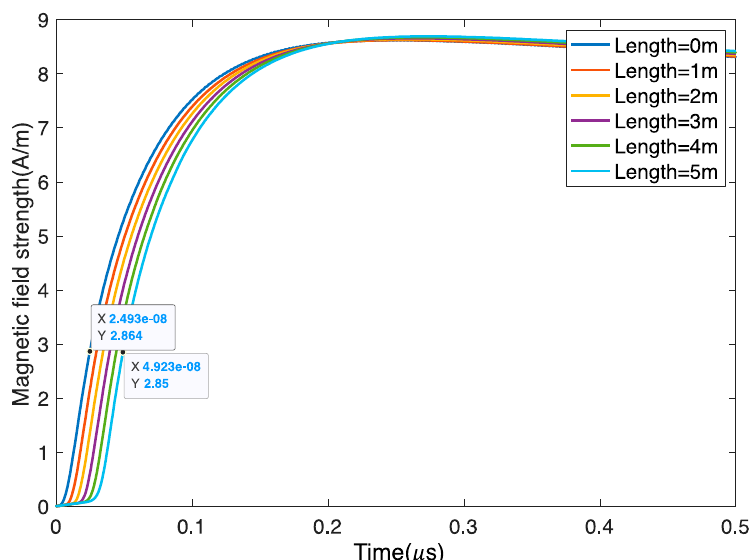
Figure 14. Influence of the coaxial cable length on the signal. With an increase in the length, the signal gradually becomes slower and the amplitude decreases, but the influence is